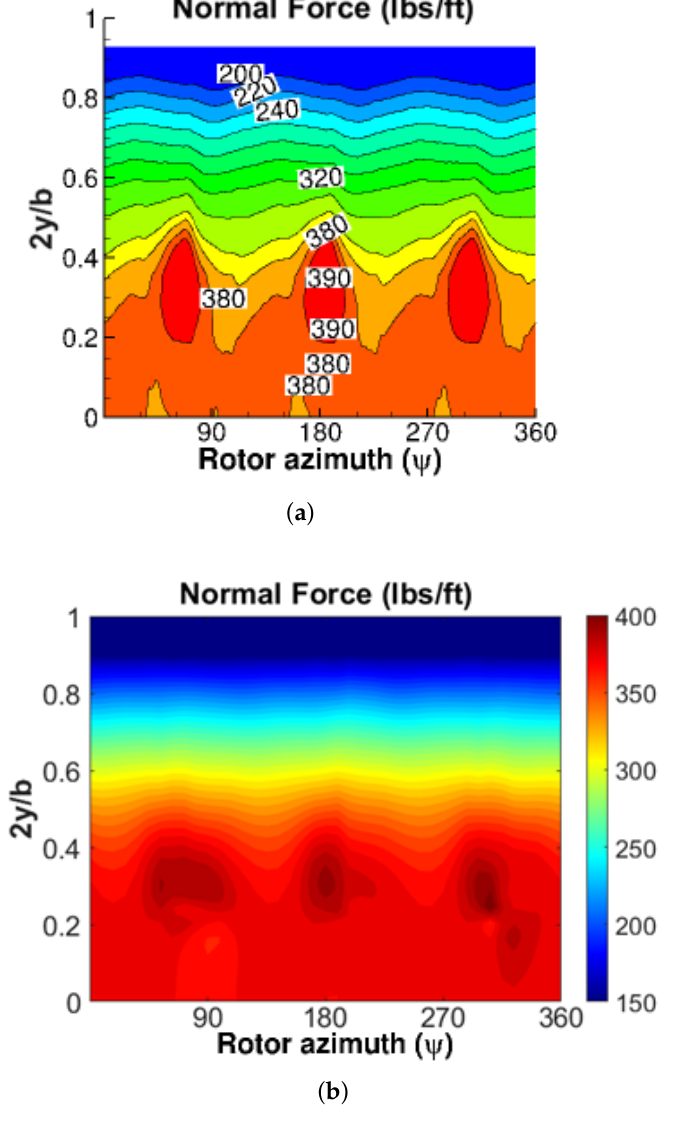
Figure 12. Comparison of the contours of the sectional normal force on the wing during the last proprotor revolution, α = 5 ◦ , V ∞ = 220 kts, Ω = 517 RPM. ( a ) CFD [18]; ( b )